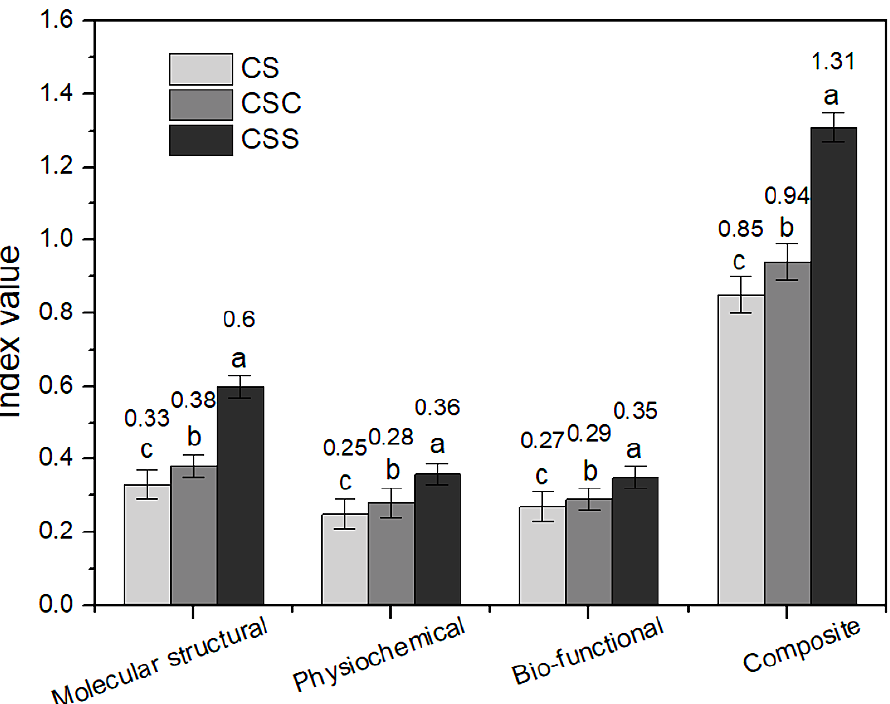
Figure 9. Composite index of chitosan biochemistry performance. Different lowercase letters under the data in the same group indicate significant difference ( p < 0.05).